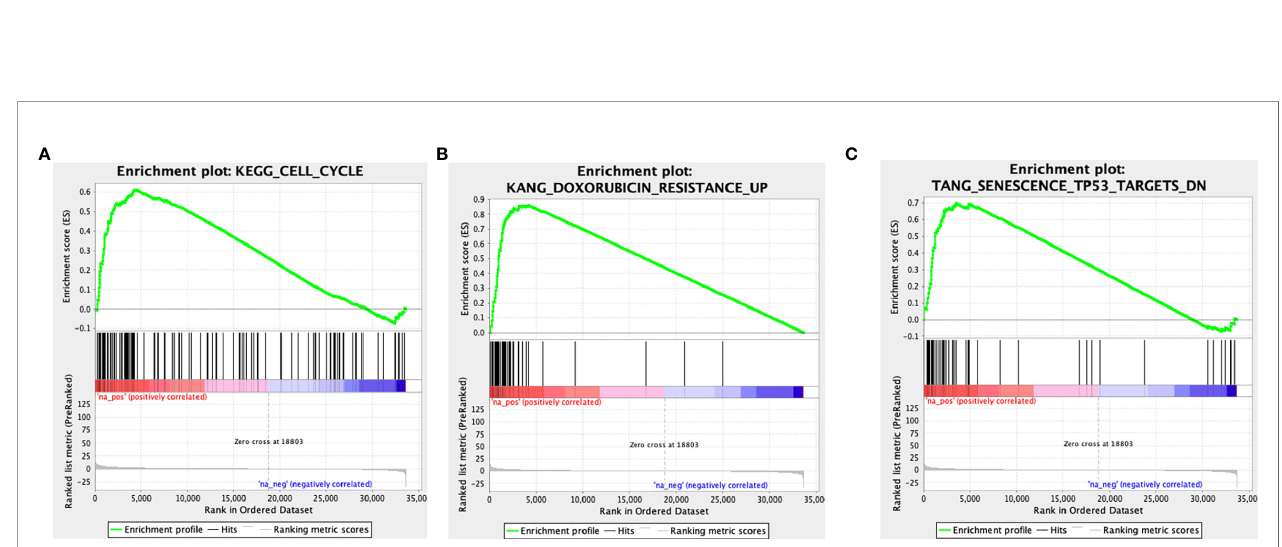
FIGURE 3 | LncRNA AC007639.1 regulates the susceptibility of liver cancer to doxorubicin by inhibiting the p53 pathway, analyzed by GSVA. (A) The effect of lncRNA AC007639.1 on cell cycle (p < 0.001); (B) The effects of lncRNA AC007639.1 on doxorubicin resistance (p < 0.001); (C) The effects of lncRNA AC007639.1 on p53 target genes (p <